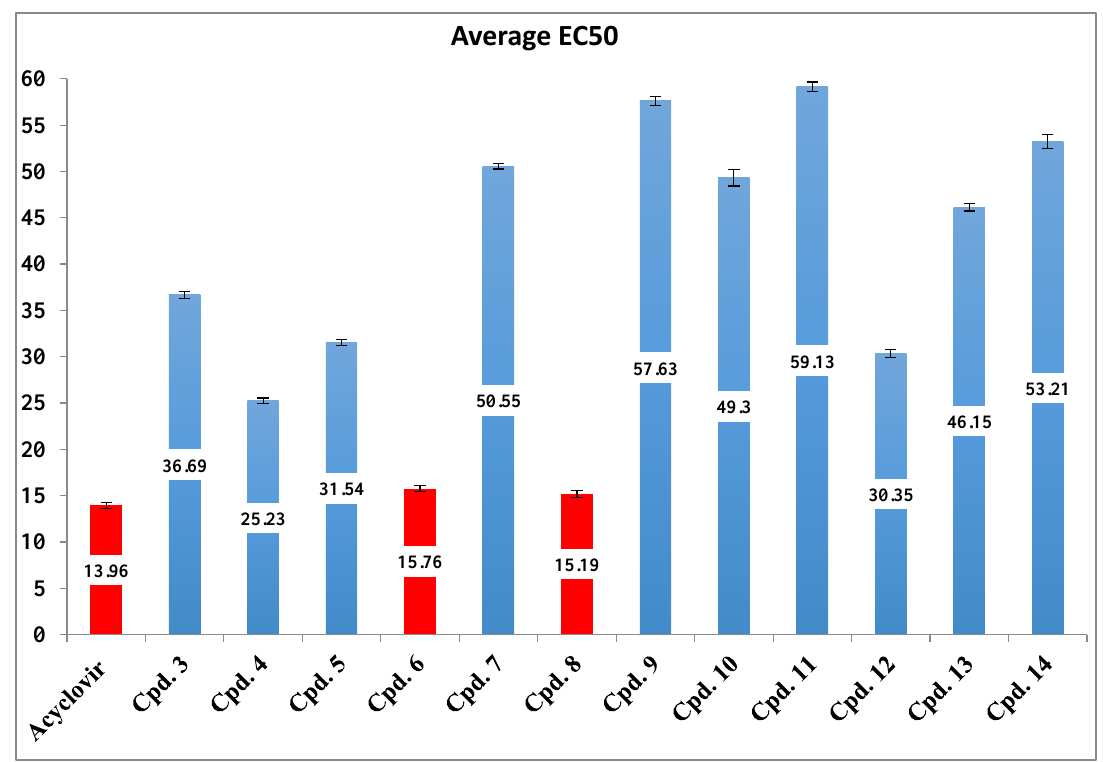
100 * Most potent compounds. From Table 1, we can see that the tested compounds exhibited varied antiherpetic activity compared to that of ACV, yet 6 μg/mL of all compounds and ACV could not pre- vent CPE presentation. A concentration of 12 μg/mL also could not prevent CPE except for compounds 4 , 6 , and 8 , which gave a CPE inhibition of 14, 30 and 32%, respectively.